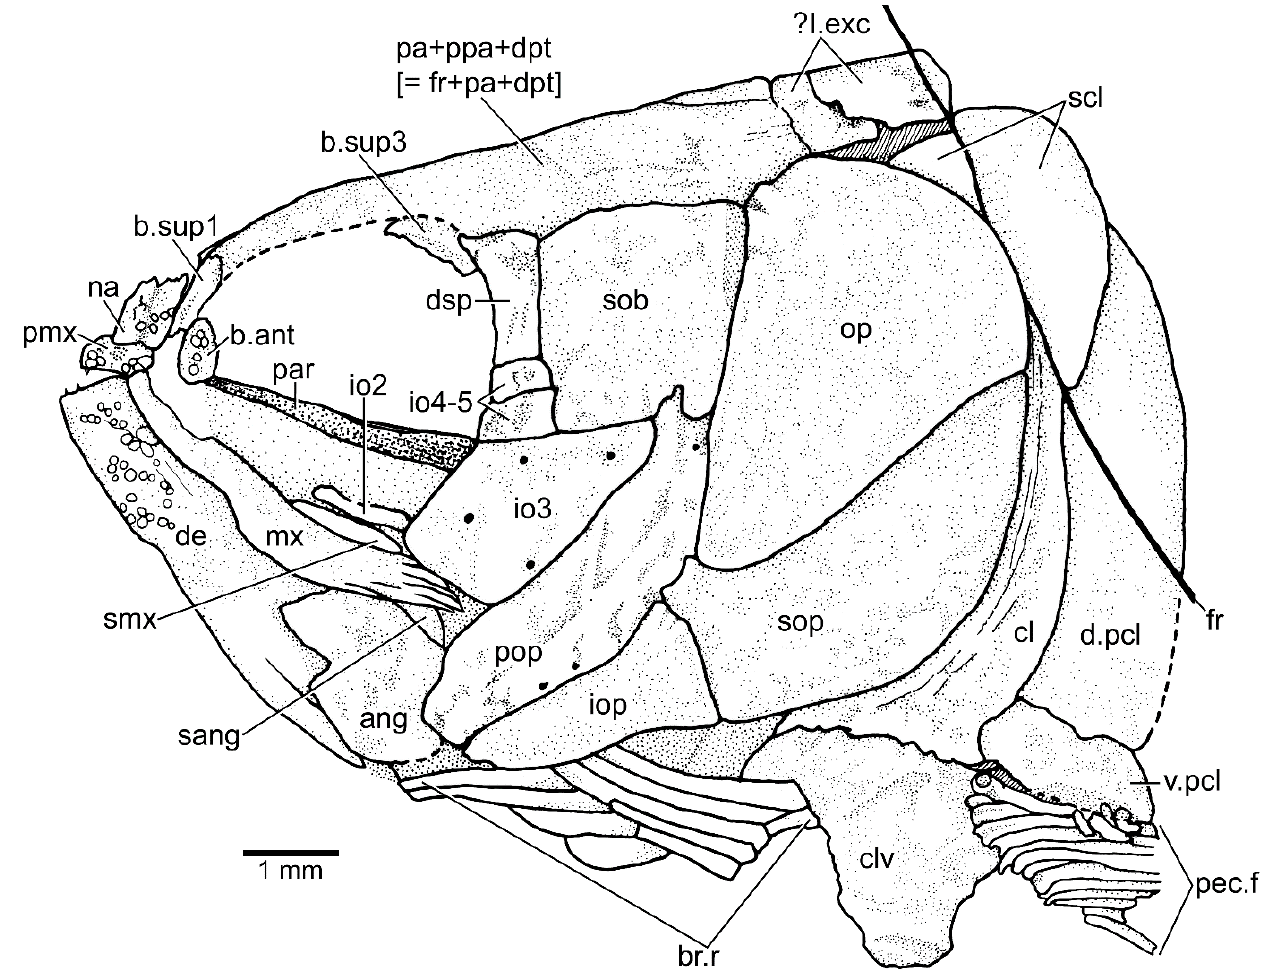
Figure 4. Seinstedtia parva gen. et sp. nov. Head and pectoral girdle of holotype MLU Sei.2010.76 in lateral view. Abbreviations: ang, angular; b.ant, broken antorbital bone?; br.r, branchiostegal rays; b.sup1, 3, supraorbital bones 1, 3; cl, cleithrum; clv, clavicle; de, dentalosplenial (=dentary); d.pcl,